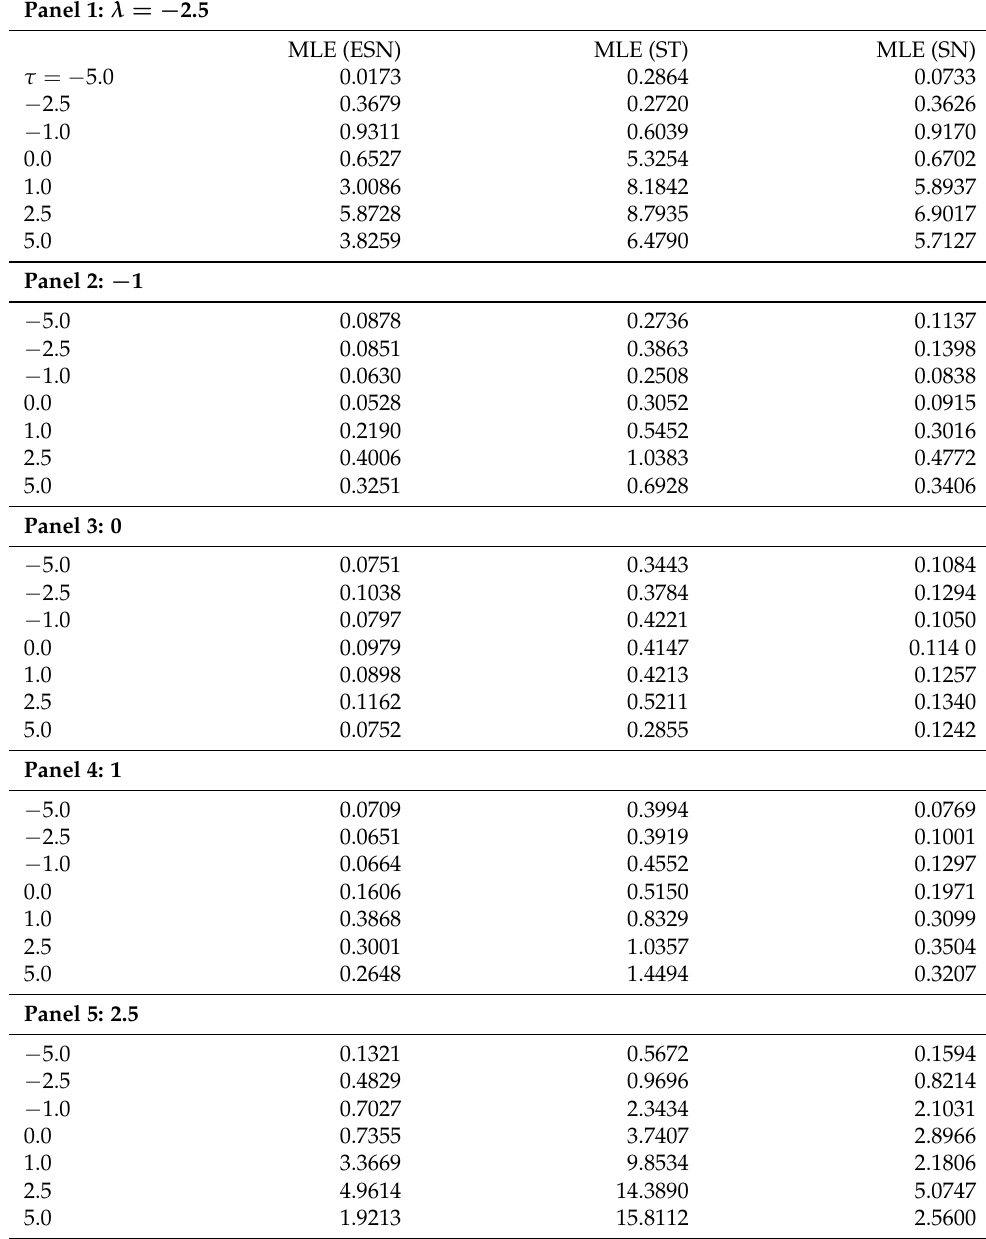
Table 15. Root mean square errors in the